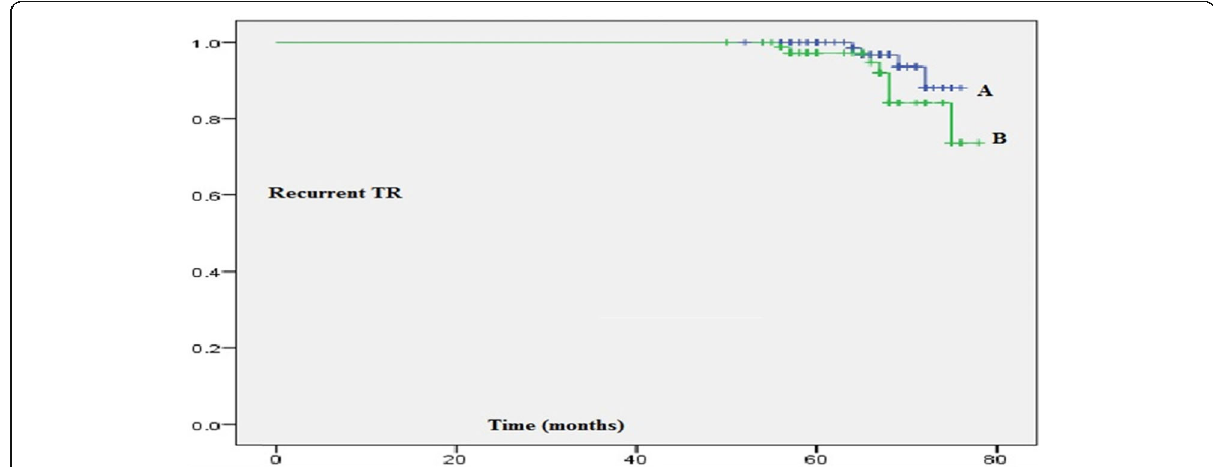
Fig. 5 Freedom from recurrent TR at different follows up periods in the study